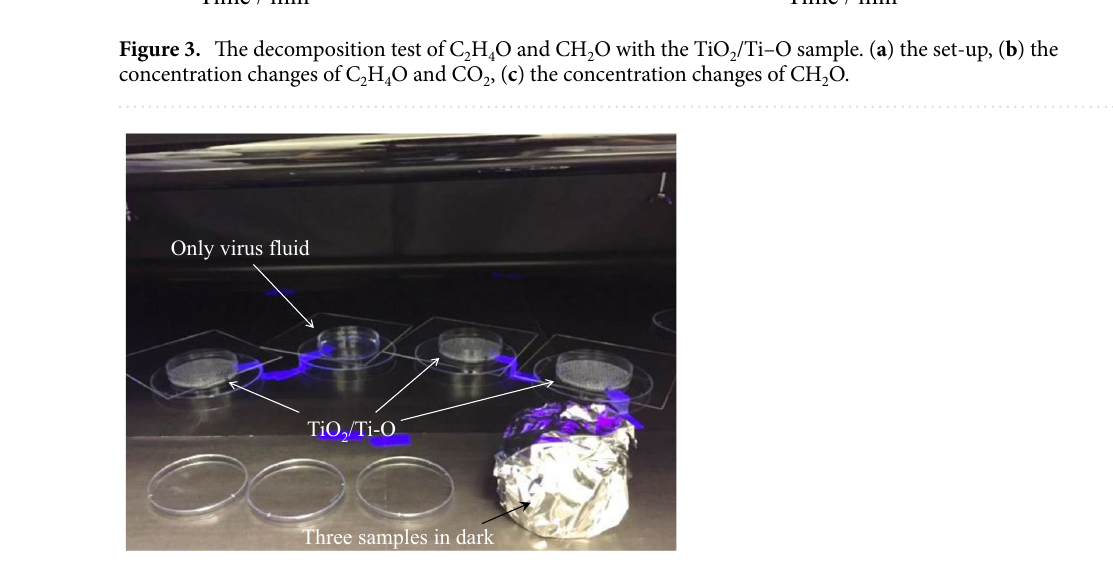
Figure 4. The set-up of antiviral test by using influenza virus under UV irradiation and in